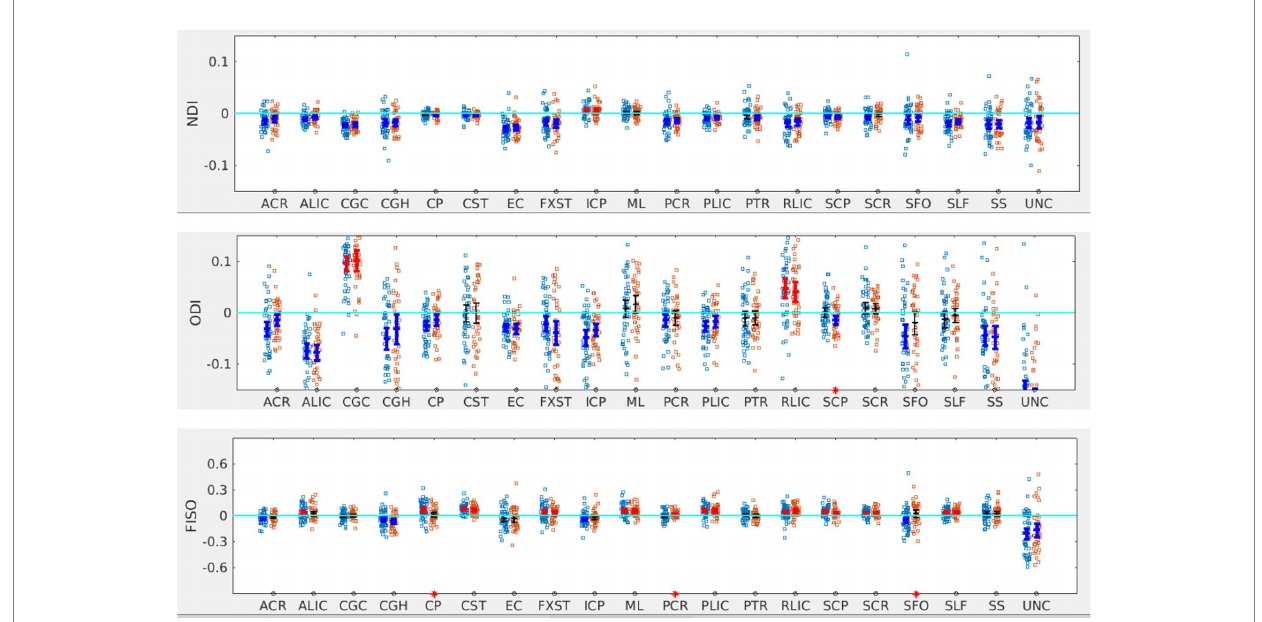
FIGURE 5 LI plotted for each of the 87 participants for the 20 bilateral tracks for NODDI metrics comparing SOR (blue dots) to non-SOR (red dots) means with 95% CI are resented in the figure for SOR and Non SOR, 95% CI bars in red represents significant right lateralization (positive LI) of the tract while blue bar represents significant left lateralizatin (negative LI) of the tract. Red asterisks on the X axis represent tracts for which difference between SOR vs. non SOR was significant at p <